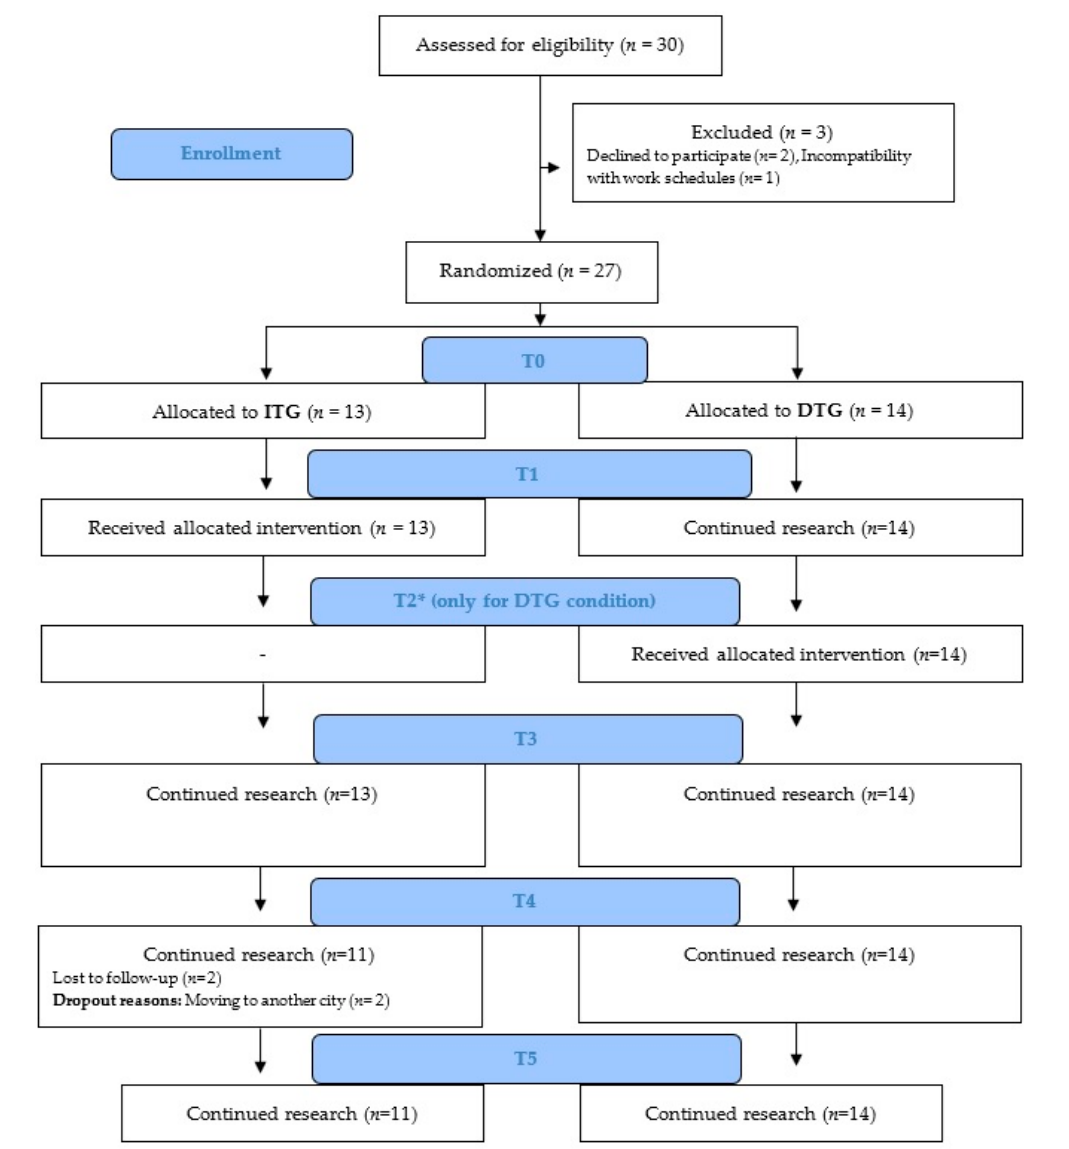
Figure 1. CONSORT diagram illustrating participant flow in the study. Note: ITG: Immediate treatment group; DTG: Delayed treatment group; T0: Pre-treatment; T1: Immediate treatment group post-treatment; T2: Delayed treatment group post-treatment; T3: 1-month follow-up; T4: 3-month follow-up; T5: 6-month follow-up.